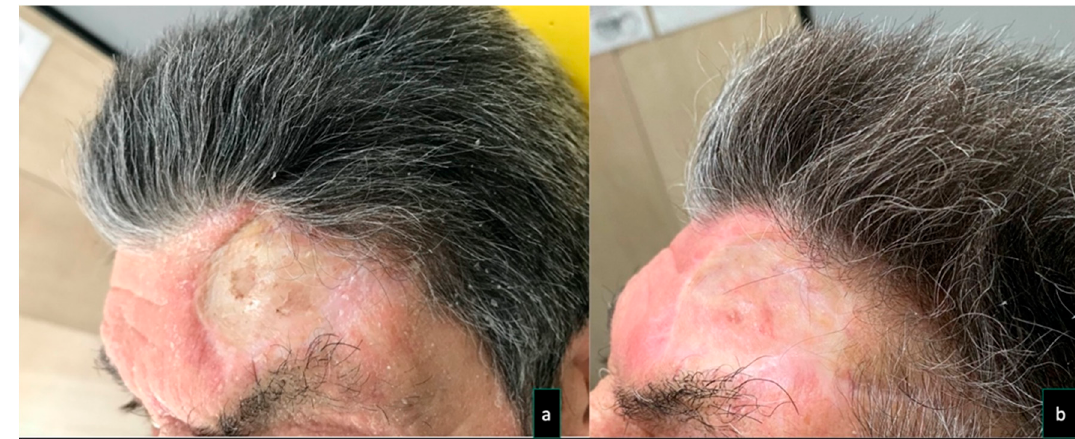
Figure 2. Case 3. A 74 -year old man underwent surgical excision for a recurrent left tuber maxillae squamous cell carcinoma. The patient previously underwent a homolateral neck dissection and radiation therapy, resulting in a depleted vessel neck. For these reasons, a pedicle superficial temporal artery flap (7 × 7 cm) was raised and used to reconstruct the oral defect. The flap donor site was repaired with a skin graft. Five sessions of a 20 mg/mL cross-linked hyaluronic acid (HA) filler (Hyamira Basic, Nyuma pharma ® , Arona, Italy) was injected into the grafted area. About 0.2 mL of HA per session was injected over a total of 5 sessions, spaced 30 days apart. After the HA was injected into the graft site, a better skin quality with a more elastic tissue, and a less depressed appearance of the area were noticed. ( a ) The concave appearance of the grafted site was improved, following several sessions of cross-linked HA injections ( b ).